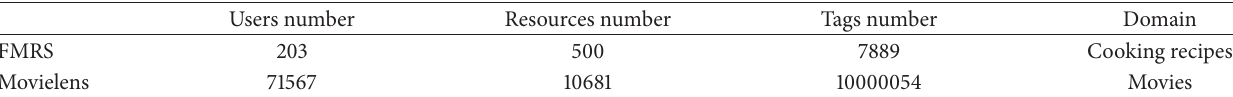
Table 1: The details of FMRS and Movielens data